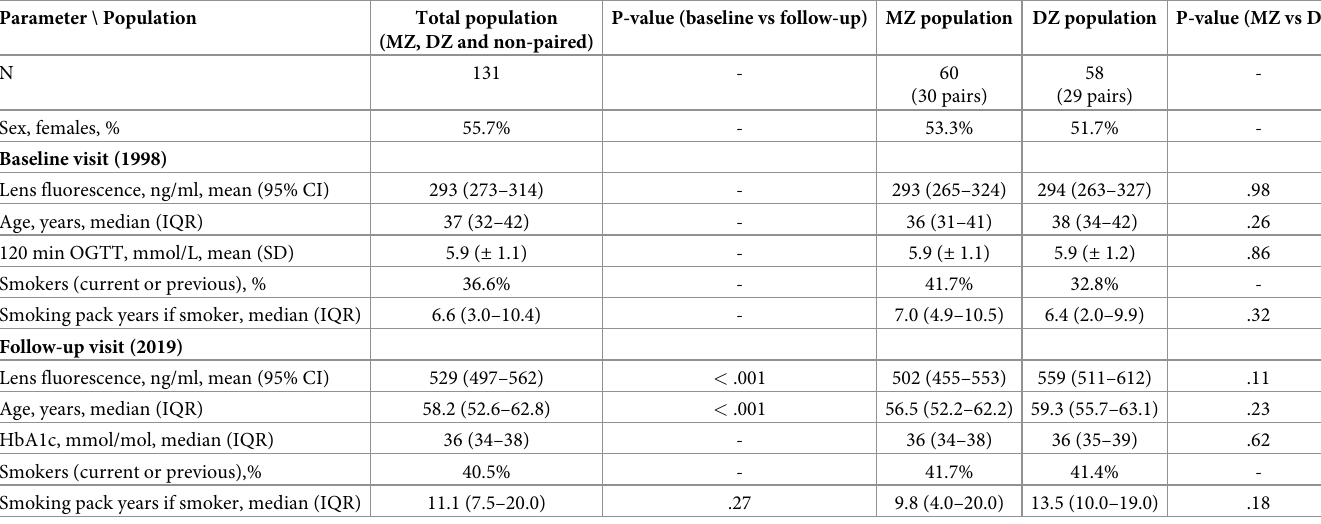
Table 1. Characteristics of study population. Parameter \ Population